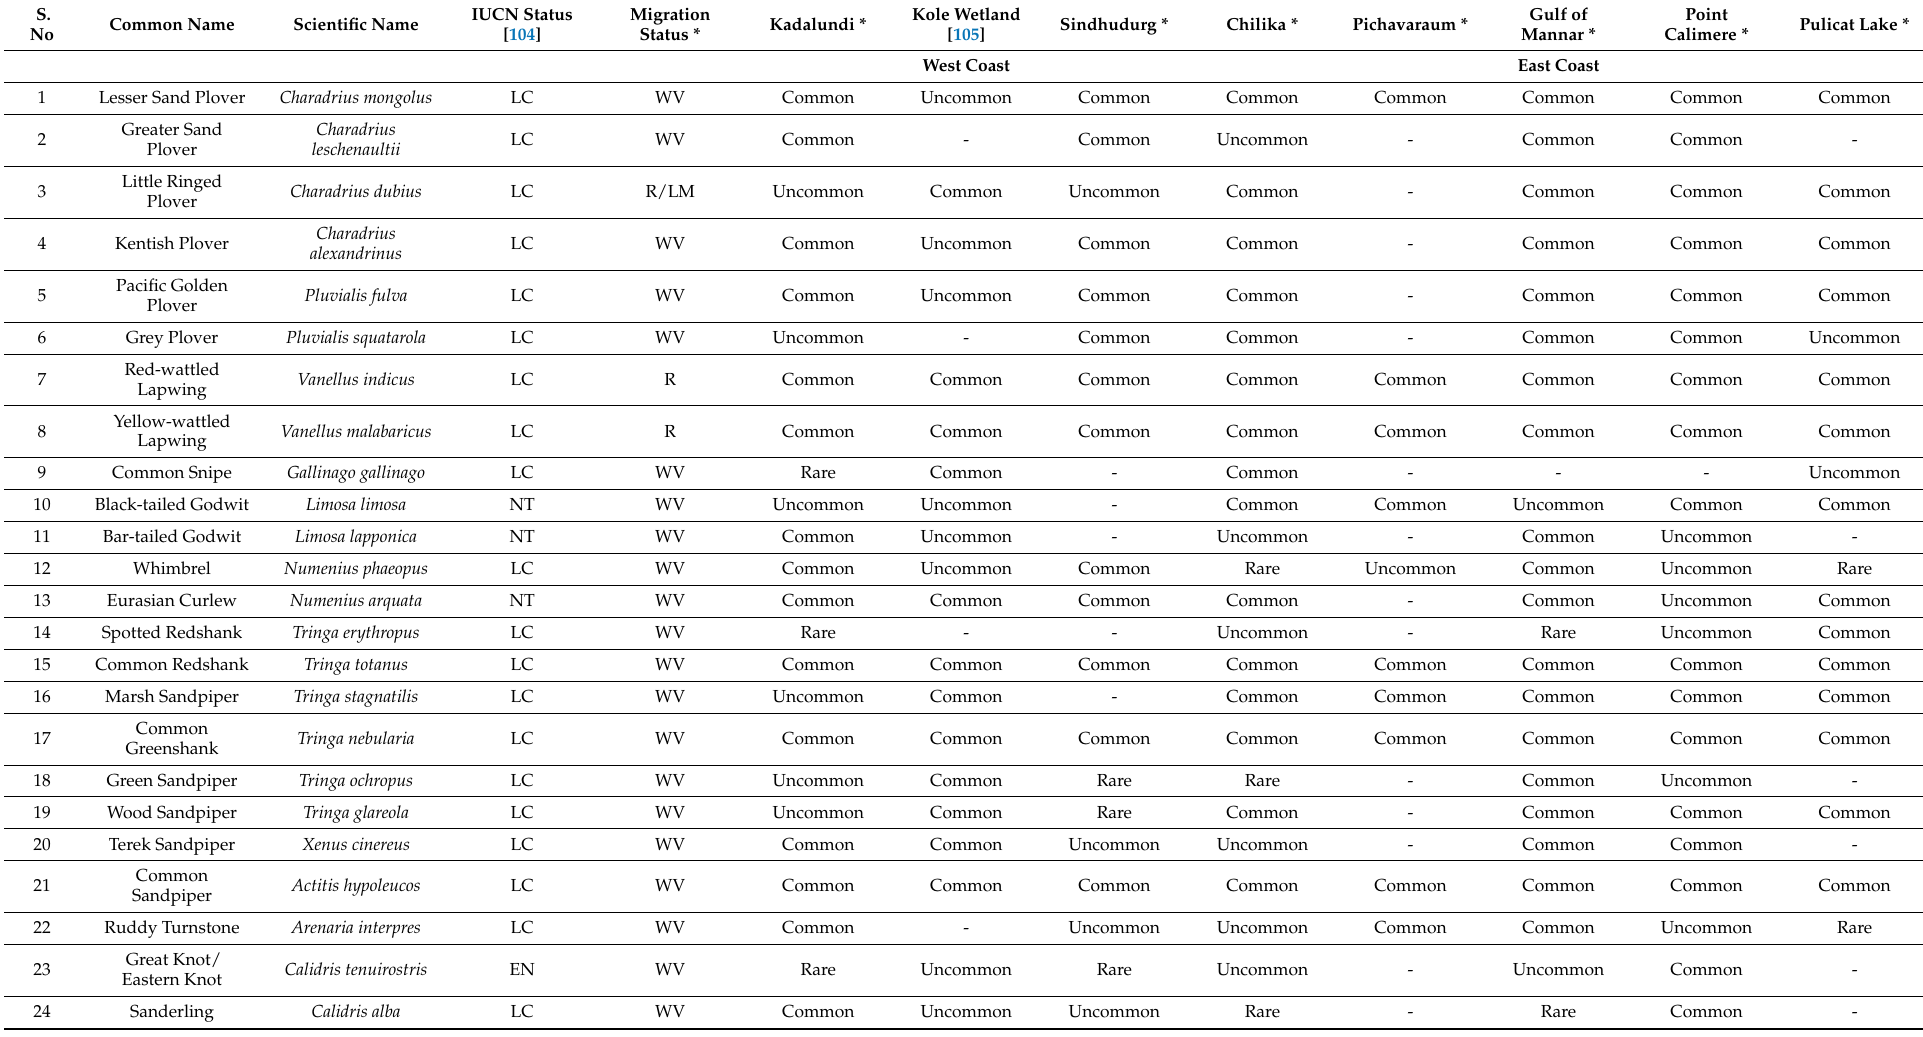
Table 1. List of shorebirds documented from east and west coast of